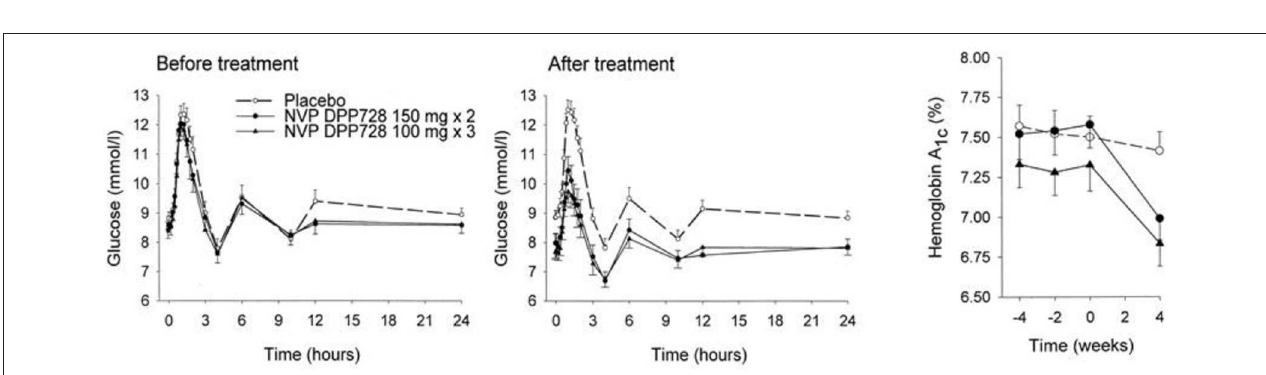
FIGURE 2 | Plasma levels of glucose and insulin after administration of glucose (150mg) through oral gavage to C57BL/6J mice which had been fed normal diet and given treatment with the DPP-4 inhibitor NVP DPP728 in the drinking water for 8 weeks. Controls were given drinking water without NVP DPP728. Means ± S.E.M are shown ( n = 16 in each group). Area under the curve for glucose was significantly lower and area under the curve for insulin was significantly higher with NVP DPP728 than with controls. Data from Reimer et al. (47).